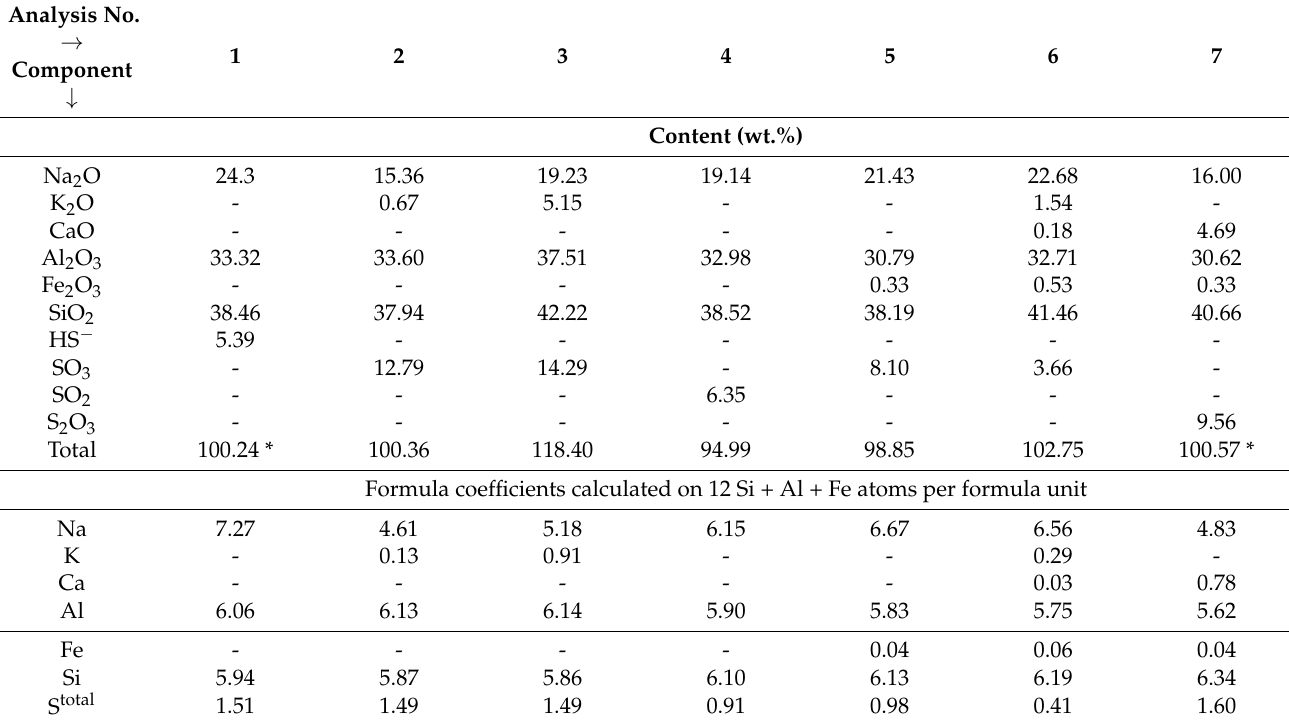
Table 5. Representative chemical data (wt.%) of the products of synthesis and analyses. The analyses numbers correspond to Experiment 1 (1), Experiment 1a (2), Experiment 1b (3), Experiment 2